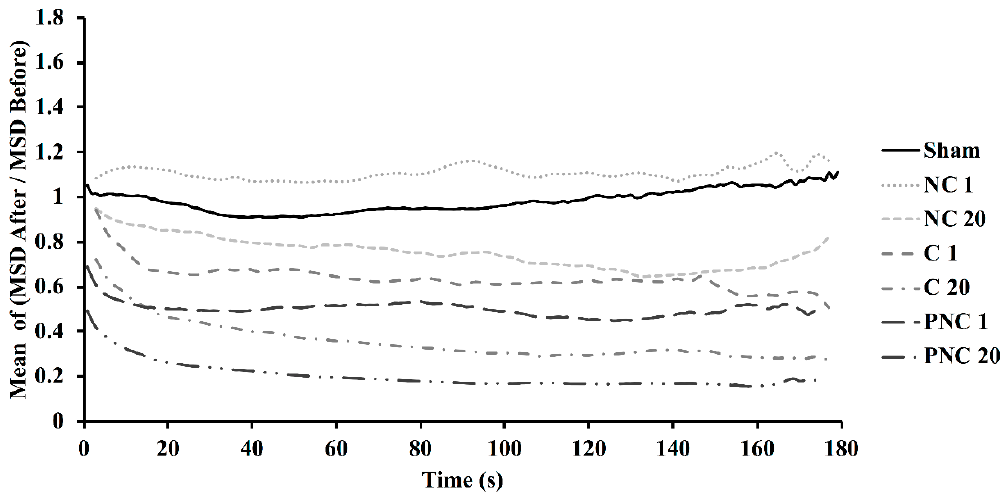
Figure 4. Ratios of the pre- and post-nsPEF means of cumulative MSD over 180 s for all lysosome tracks in cells in the presence or absence of external Ca 2+ , or in the presence of PEG without Ca 2+ , are shown. Exposures consisted of 1 or 20, 600-ns duration pulses at 16.2 kV/cm, or a sham exposure. By fitting the MSD curve for each track with the parabolic expression (Equation (1)), both the diffusion coefficient and particle velocity are yielded [7,16]. The diffusion coefficients for each condition, before and after exposure (B and A, respectively), are represented in the box plots in Figure 5. Diffusion coefficients decrease following exposure by a statistically significant amount for C 20, PNC 1, and PNC 20, according to the K-S test at alpha = 0.01. Diffusion coefficients are higher, although not significantly, for cells within PEG-containing solution.